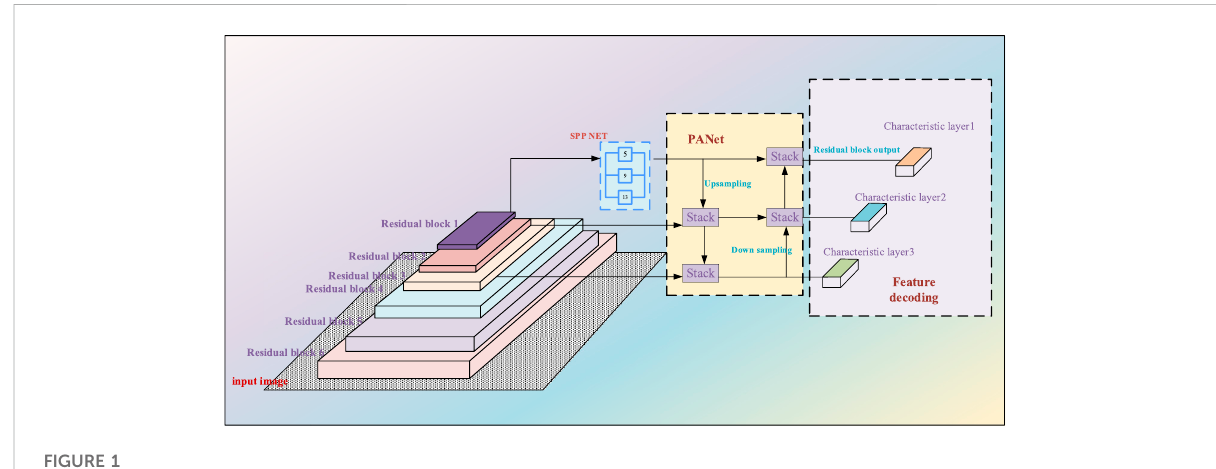
FIGURE 1 The YOLOv4 network